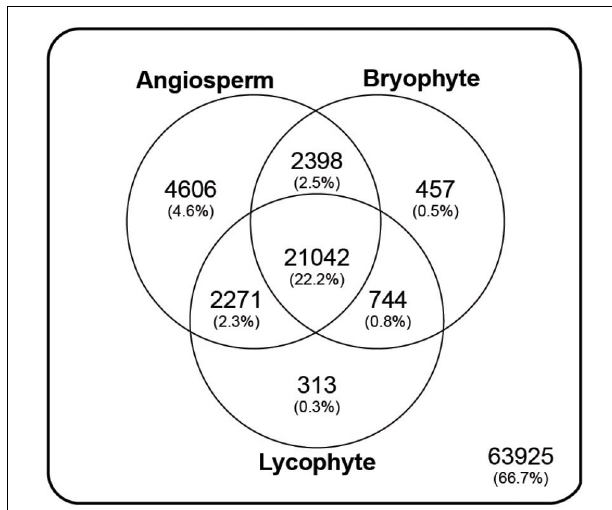
FIGURE 3 | Taxonomic summary of the annotated Polypodium amorphum reference transcriptome. Of the 98000 total genes, 63925 were not assigned to an orthogroup in the Plant Tribes classification (Wall et al., 2008). All remaining genes were assigned to an orthogroup with a predicted protein in the genome of at least one angiosperm species, the lycophyte Selaginella moellendorffii , and/or the bryophyte Physcomitrella patens